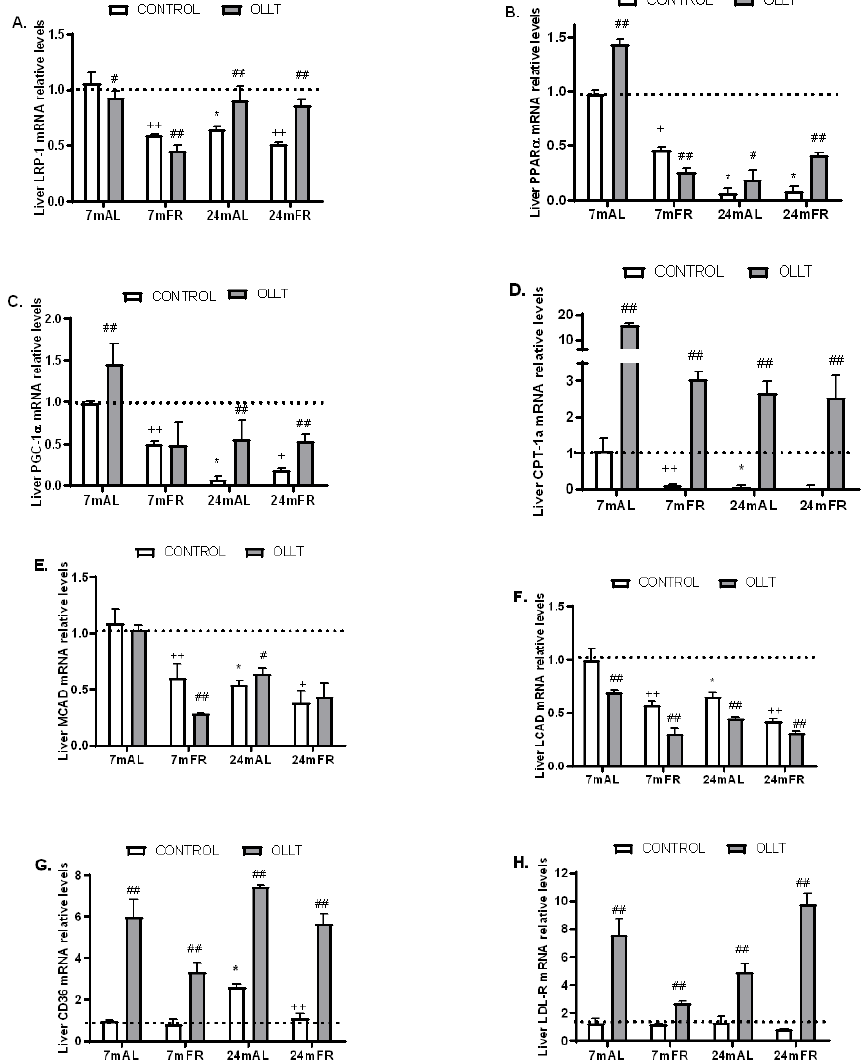
Figure 4. mRNA relative levels of LRP-1 ( A ), PPARα ( B ), PGC- 1α ( C ), CPT-1a ( D ), MCAD ( E ), LCAD ( F ), CD36 ( G ), and LDL-R ( H ), in the liver of 7- and 24-month-old rats fed ad libitum (AL) or food-restricted (FR), before (CONTROL) and after an oral lipid loading test (OLLT). Results are the mean ± SEM of 8–10 rats per group, conducted in duplicates. Unpaired Student’s t -test, * p < 0.05 compared to 7-month-old rats under the same feeding protocol; + p < 0.05, ++ p < 0.0001 compared to the age-matched ad-libitum-fed rats; # p < 0.05, ## p < 0.0001 compared to basal levels before a fat load of age-matched rats under the same feeding